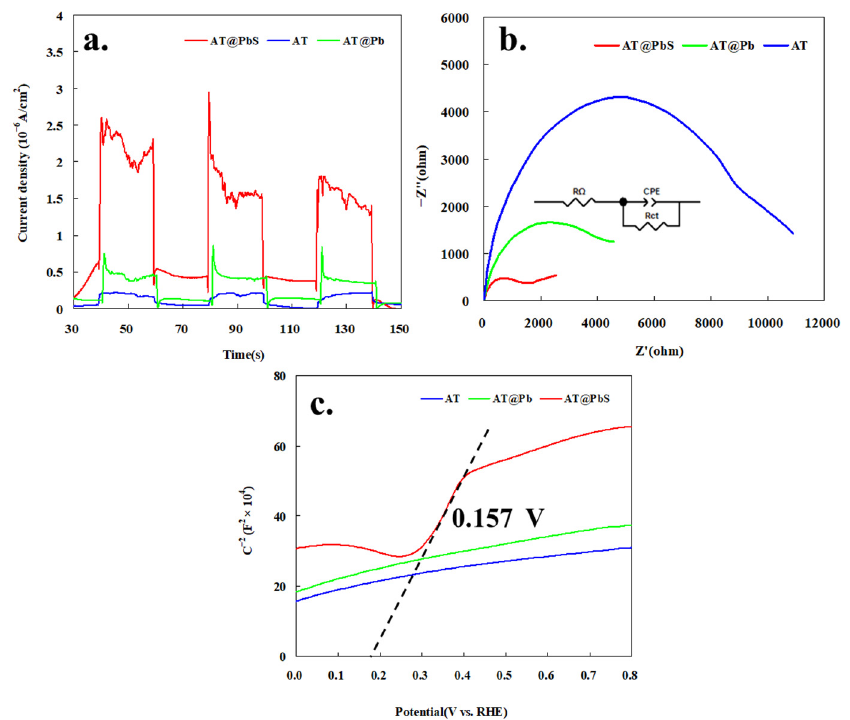
Figure 10. ( a ) Transient photocurrent responses of AT (attapulgite), AT@Pb (Pb-adsorbed saturated attapulgite), and AT@PbS (attapulgite/lead sulphide composite); ( b ) Electrochemical impedance spectra of AT (attapulgite), AT@Pb (Pb-adsorbed saturated attapulgite), and AT@PbS (attapulgite/lead sulphide composite), ( c ) Mott-Schottky curves of AT (attapulgite), AT@Pb (Pb-adsorbed saturated attapulgite), and AT@PbS (attapulgite/lead sulphide composite).